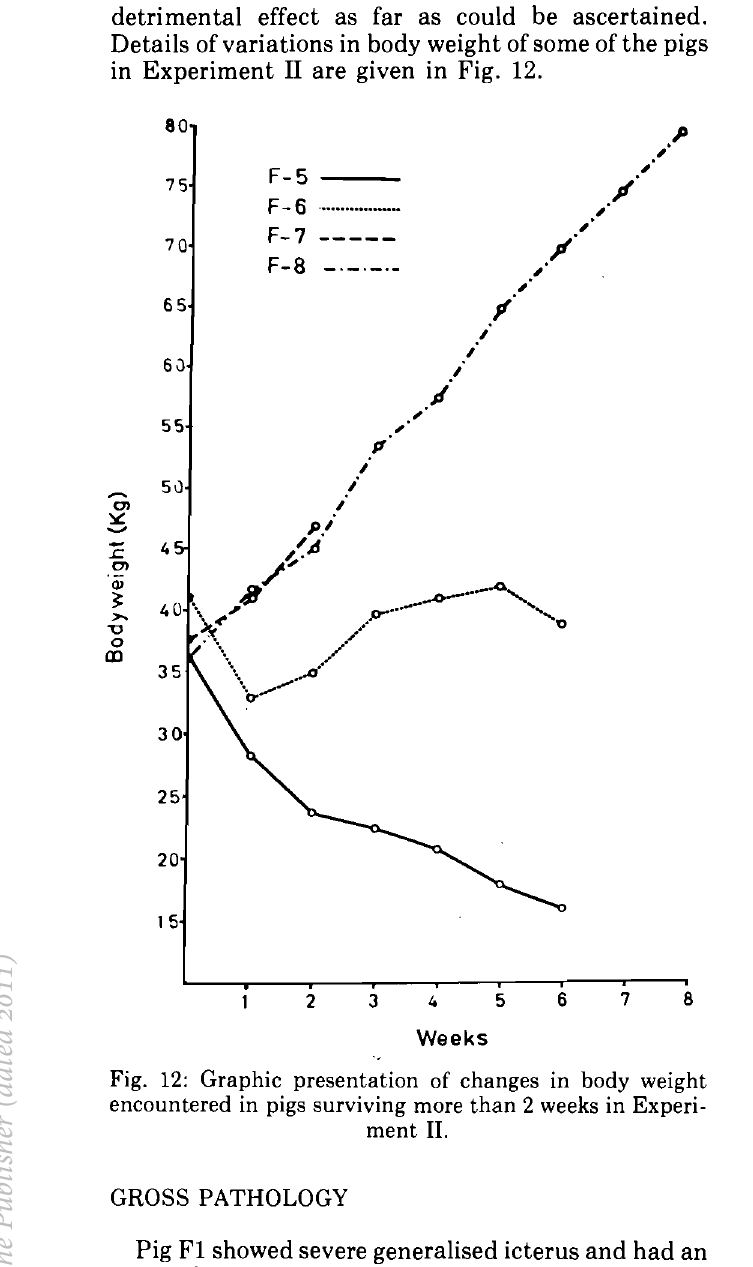
Fig. 12: Graphic presentation of changes in body weight encountered in pigs surviving more than 2 weeks in Experi ment II. GROSS